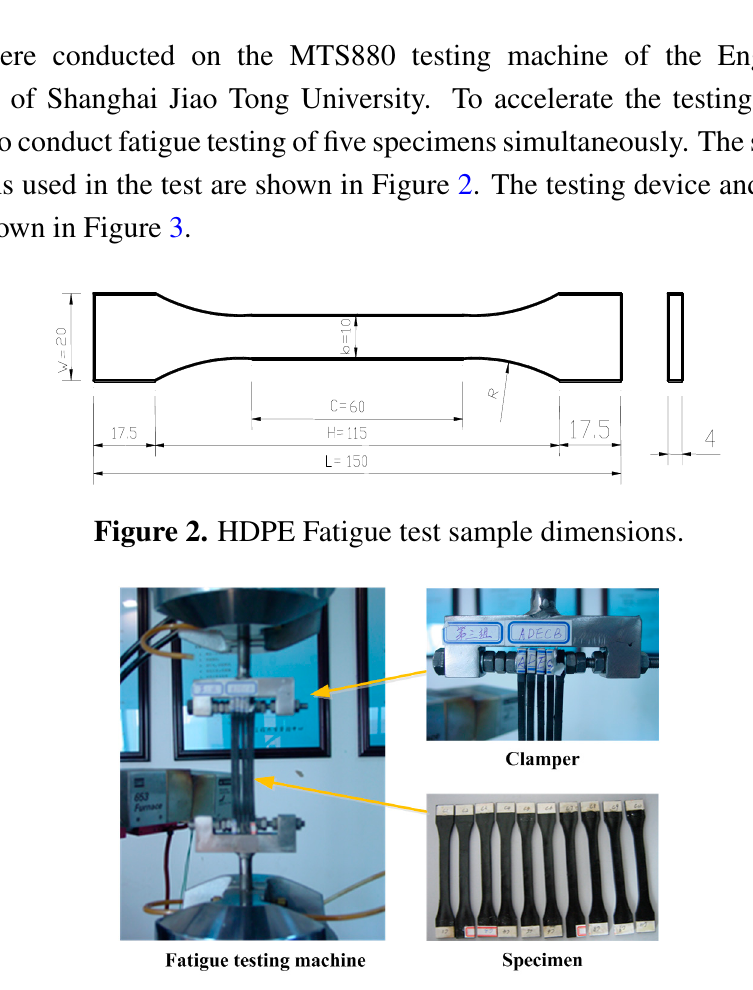
Figure 3. HDPE Fatigue test and some sample photographs.